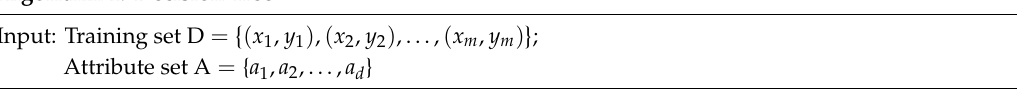
Algorithm 1. Decision